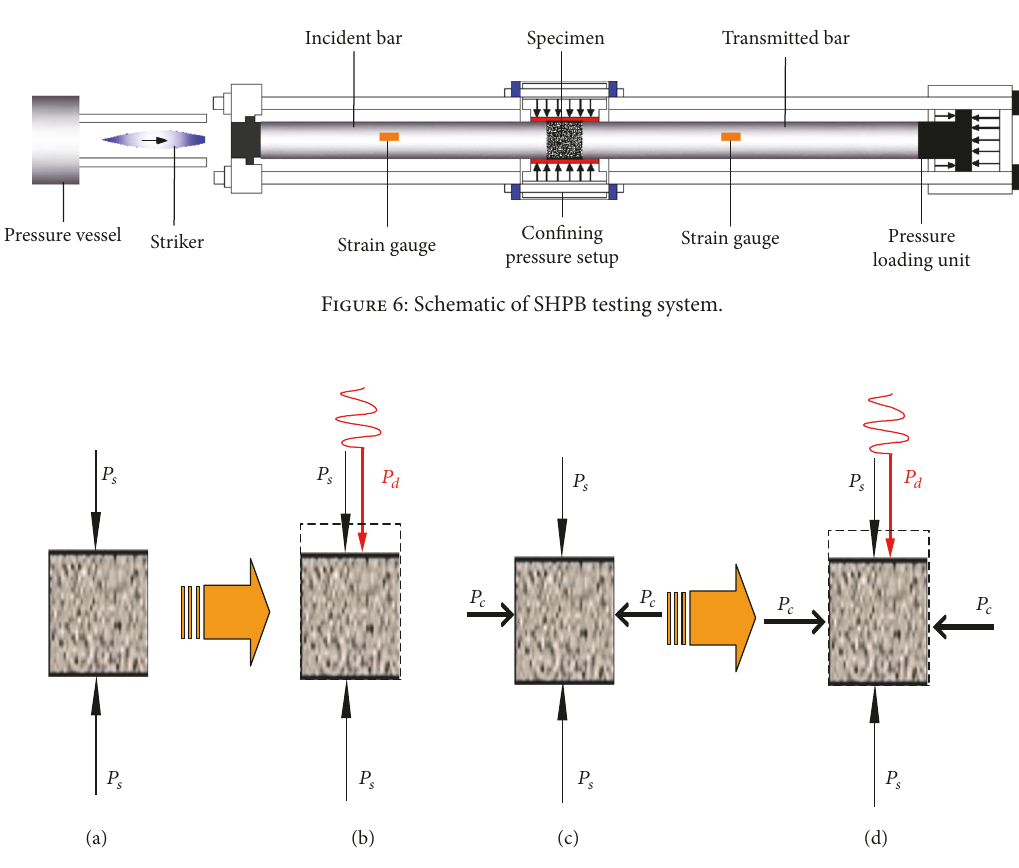
Figure 7: Mechanics diagrams of specimen under static and dynamic coupling